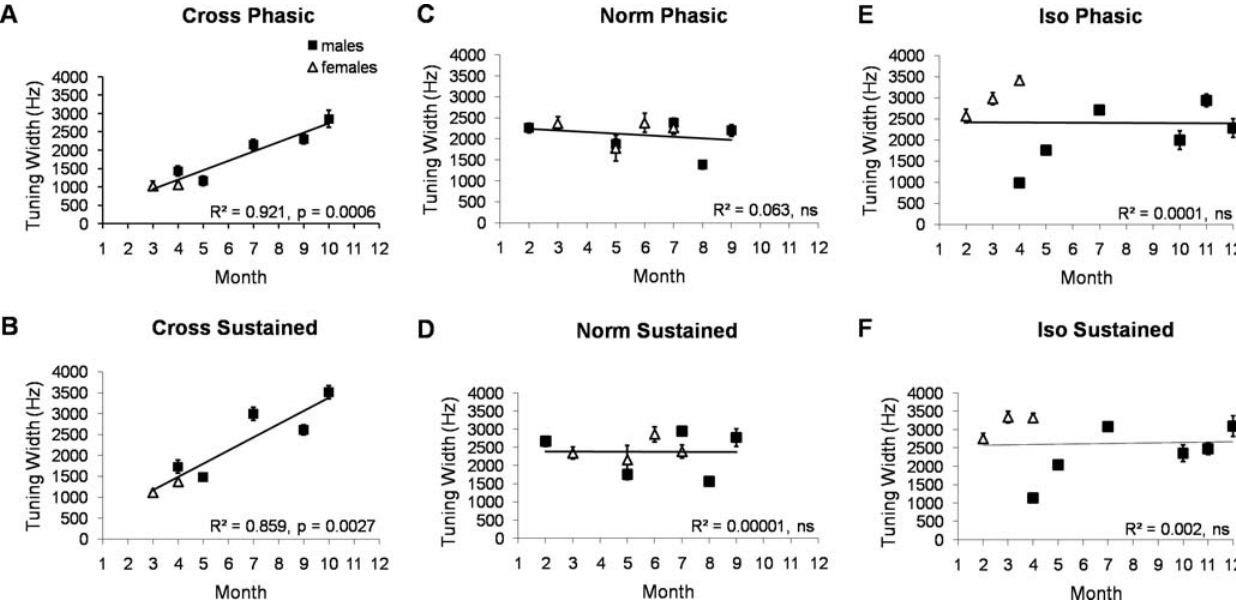
Figure 3. Tuning width of Phasic (Top) and Sustained (Bottom) responses from the CROSS (A and B), NORM (C and D) and ISO (E and F) canary groups, respectively, by month of the year. Black squares represent the average tuning width of all sites recorded from males in a given month and open triangles represent the average tuning width of all sites recorded from females in a given month, and error bars represent 6 1 SEM. The average tuning width of NORM canaries in the month of March is omitted, as only 3 sites from a single bird were recorded during that month. Regressions are drawn for each figure (data from both sexes included). R 2 values and probabilities are indicated for each scatter plot, and correspond with the regressions drawn to the average values for each month, and in both sexes. Canaries show a significant effect of season on tuning in the CROSS condition only, during both the phasic and sustained periods. Sex differences, such as those in the ISO group, are discussed in the